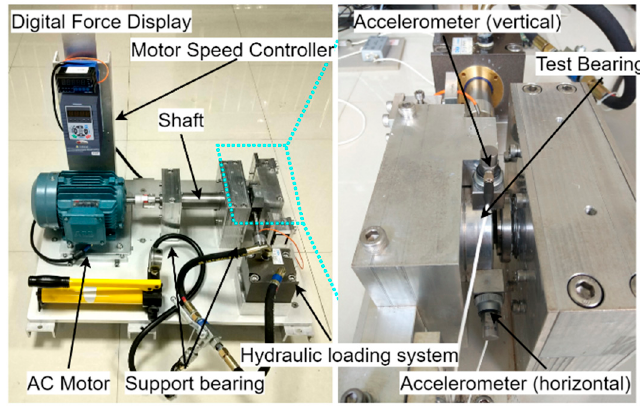
Figure 7. Bearing Accelerated Life Test Bench.